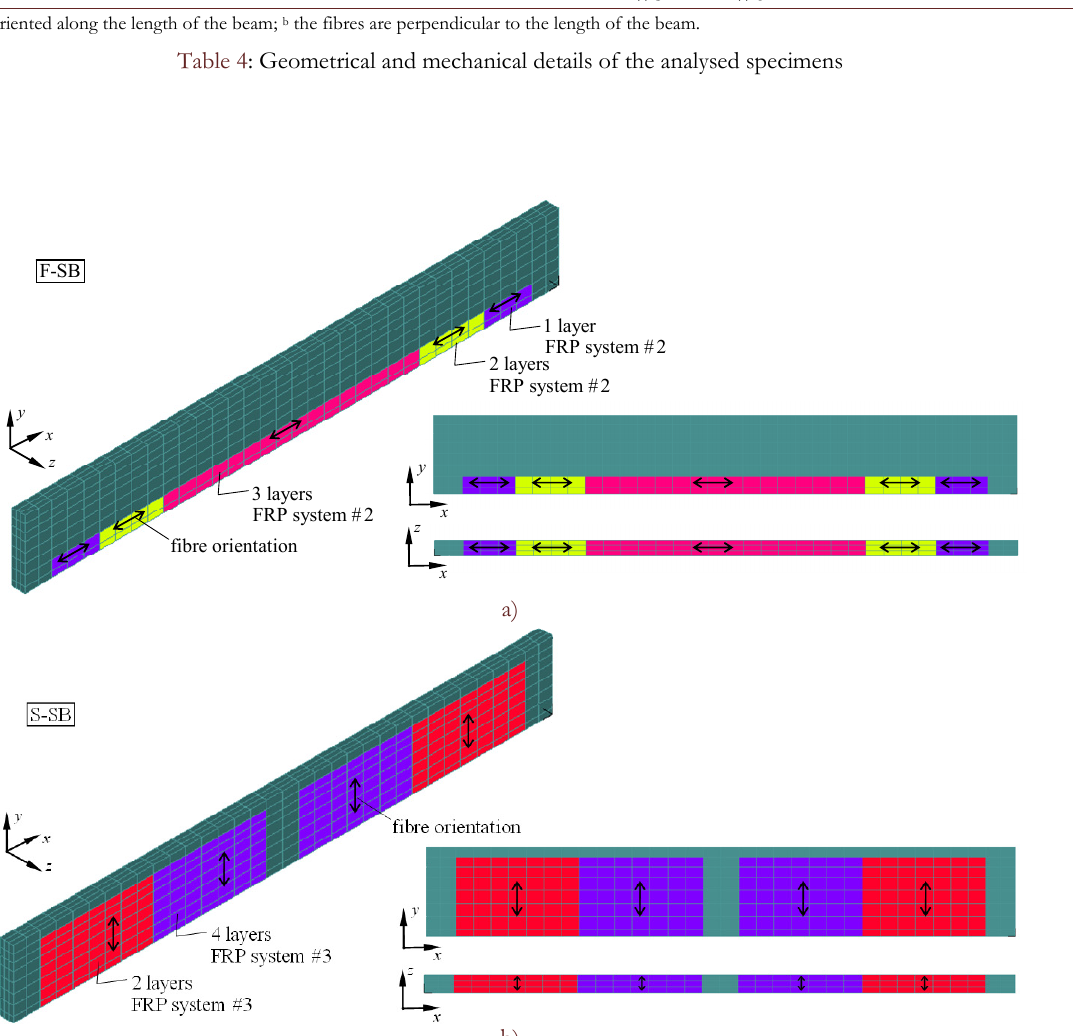
Figure 4: FE-model of two analysed specimens: a) specimen F-SB; b) specimen